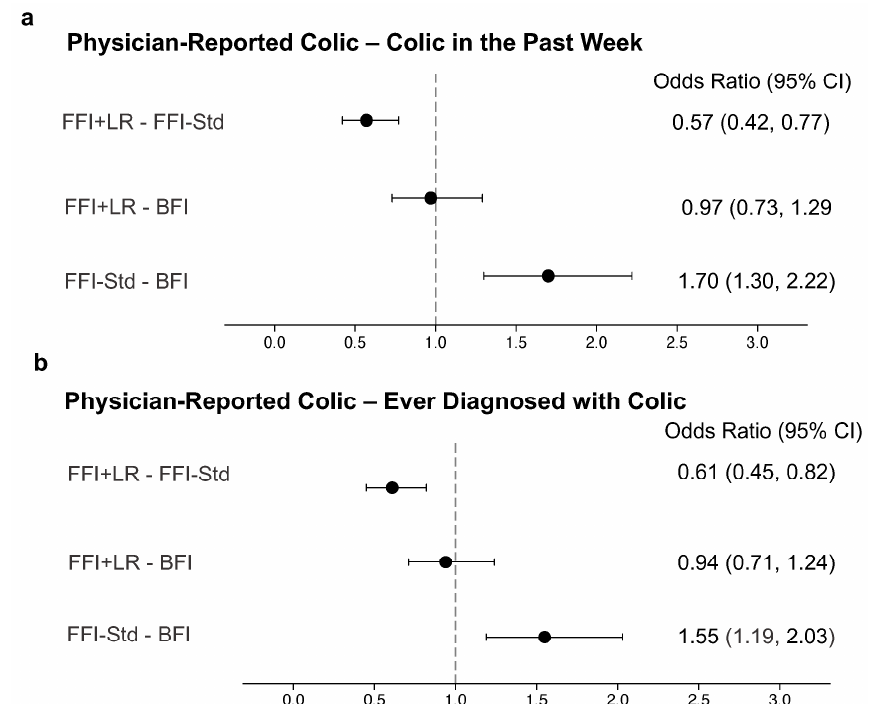
Figure 3. Odds ratios with 95% confidence interval comparing physician-reported colic between feeding groups. The vertical line shows the reference value for the odds ratios. Physician-reported colic was measured using the Feeding Practice and Gut Comfort Questionnaire (“Was your child ever diagnosed with colic?” and “Did the child have colic in the past week?”). Both outcomes were modeled using logistic regression and adjusted for study site, infant age, sex, delivery type, history of gastrointestinal disease in parents and mother’s education. BFI—Breastfed infants; FFI + LR—Infants fed formula with L. reuteri ; FFI-Std—Infants fed standard formula without any probiotic or prebiotic. n = 760 in BFI; n = 501 in FFI-Std; n = 470 in FFI + LR. ( a ) Physician-reported colic-colic in the past week; ( b )Physician-reported colic-ever diagnosed with